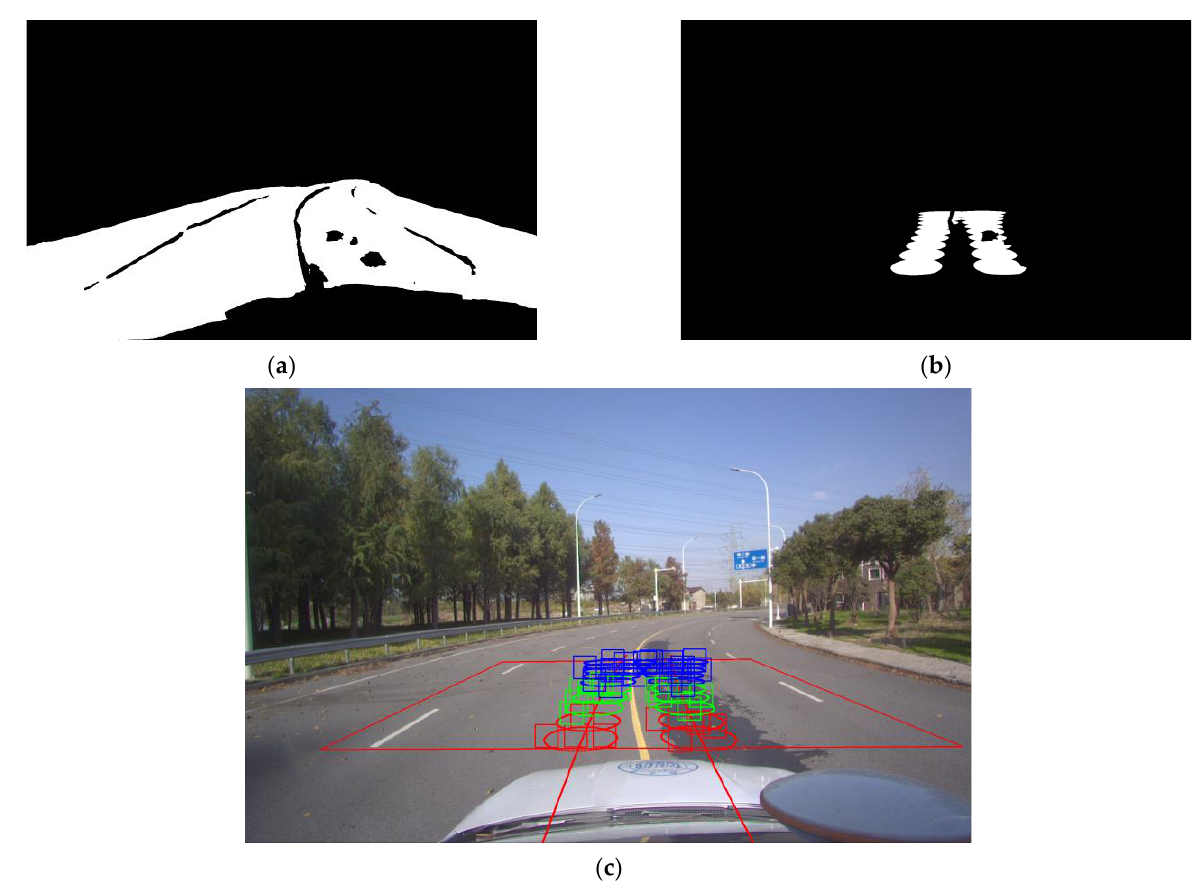
Figure 9. The extraction process of the candidate ROIs extraction method. ( a ) Drivable area mask after removing road shadow; ( b ) Confidence ellipse region mask after removing road shadow; ( c ) Candidate ROIs within each group of confidence ellipses.